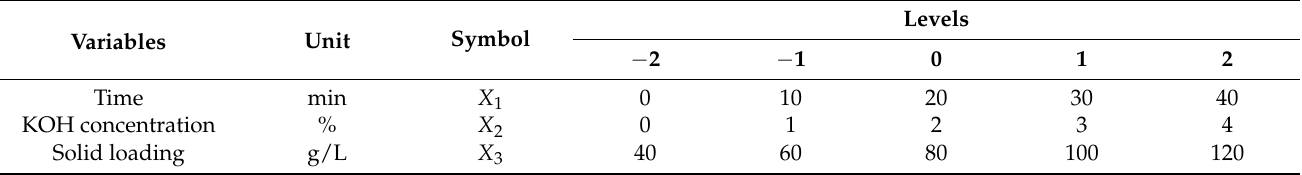
Table 1. Variables and their levels in the central composite rotatable design for experimental conditions of pretreatment.